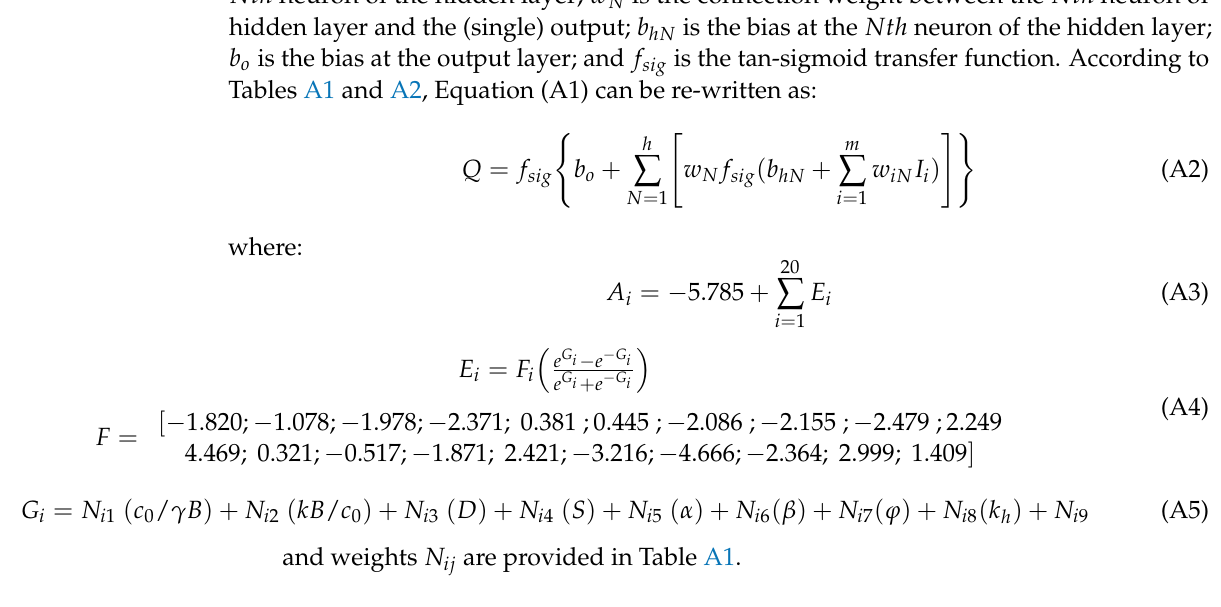
Table A2. Hidden-output weights and